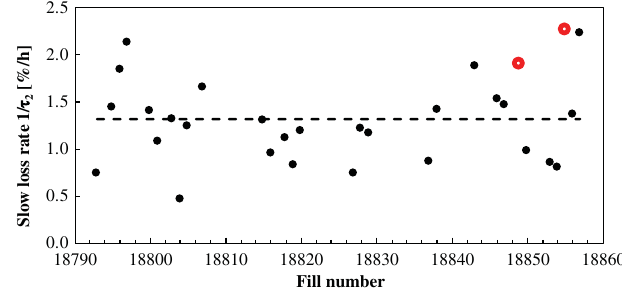
FIG. 19. Yellow beam loss rate of 30 stores. The two red marked stores had the Yellow electron lens on for 6.75 h and 5.28 h respectively, for all other stores the lenses were on between 0.45 to 1.83 h.